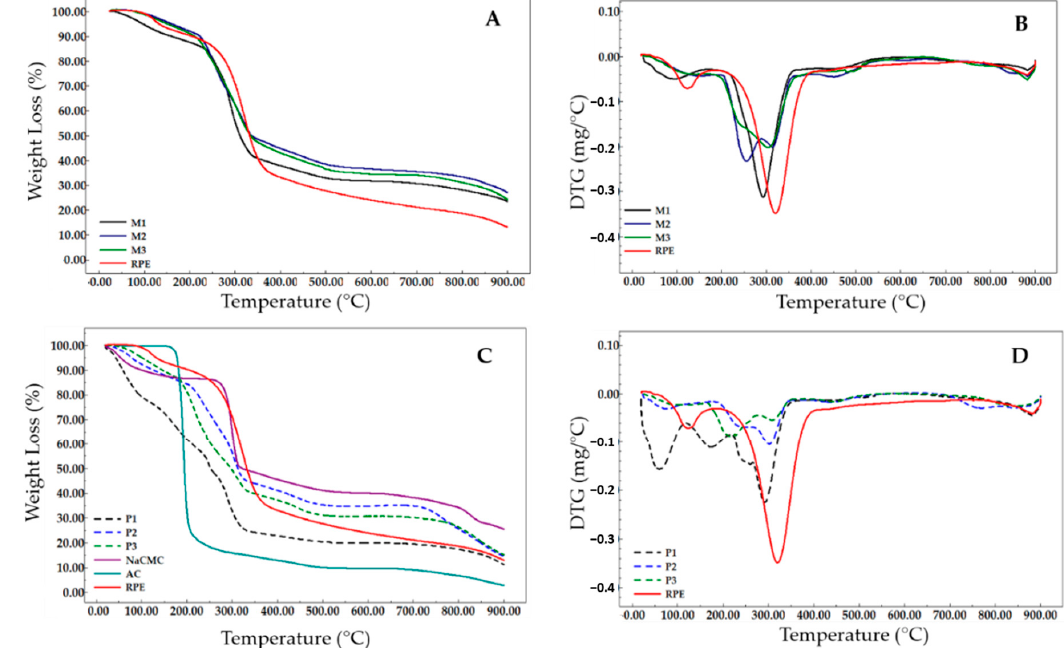
Figure 2. Thermogravimetric ( A ) and derivative thermogravimetric ( B ) curves of polymeric hydrogel membranes loaded with red propolis extract (RPE). Thermogravimetric ( C ) and thermogravimetric derivative ( D ) curves of polymeric hydrogel membranes of the controls (P1, P2 and P3), RPE, sodium carboxymethylcellulose (NaCMC) and, citric acid (CA).